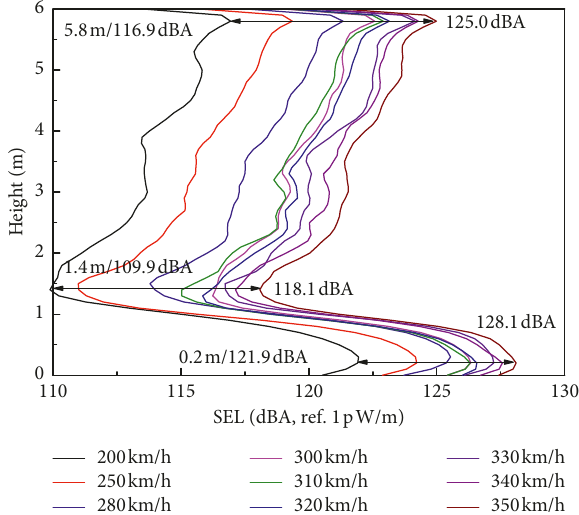
Figure 12: Vertical distribution of the exterior noise sources at different speeds (500–5000Hz).